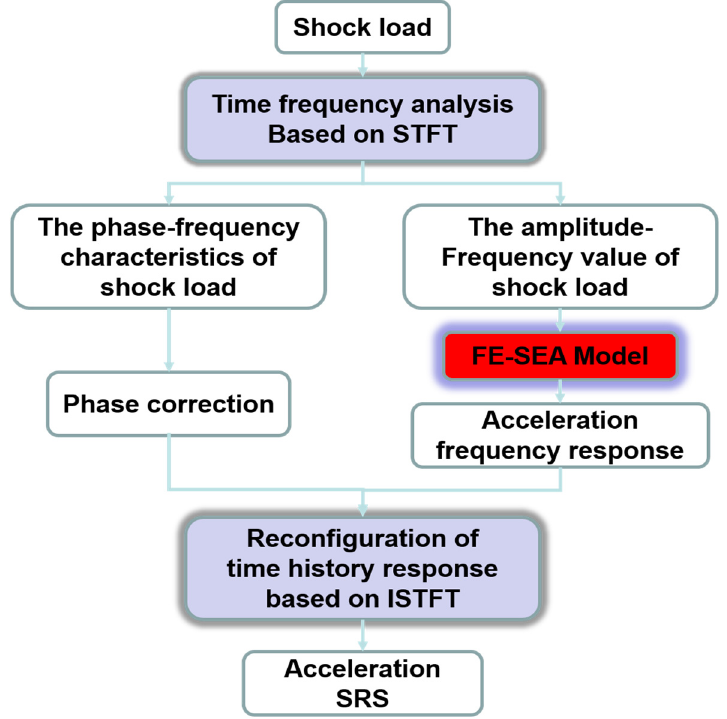
Figure 1. Flow chart for the shock response predictions